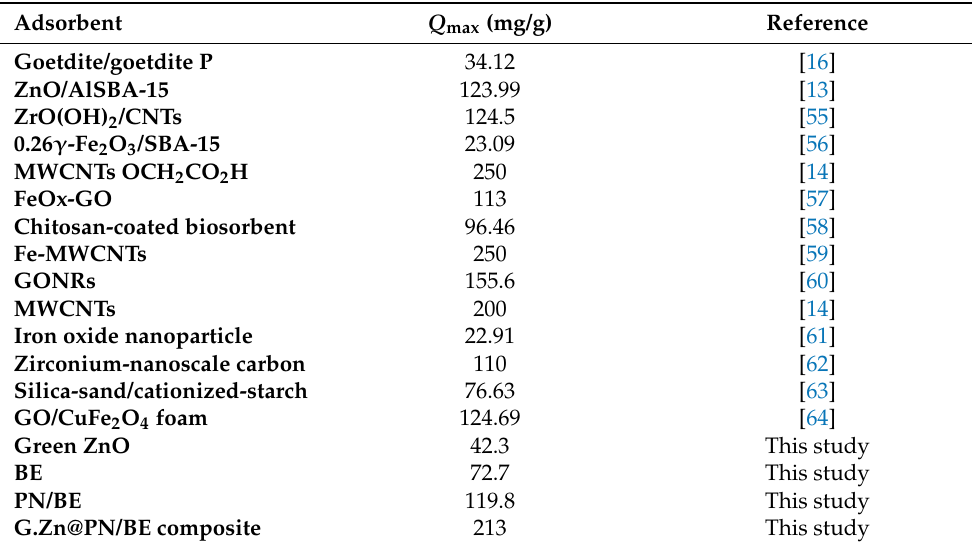
Table 3. Comparison between the As (V) retention capacity of G.Zn@PN/BE composite and other studied